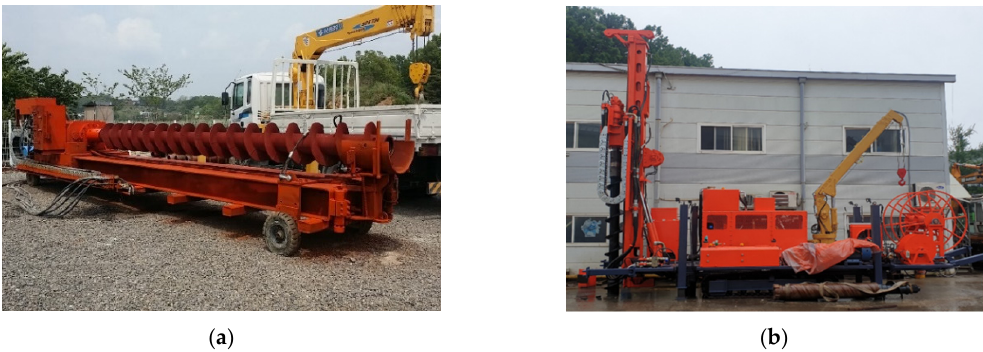
Figure 2. Comparison of boring machine: ( a ) outdated boring machine, and ( b ) newly developed high-performance MSP boring machine.